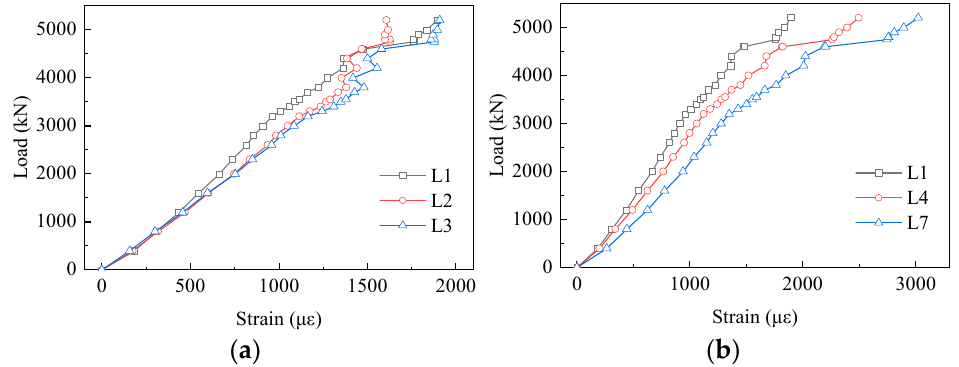
Figure 11. Load–strain curves of the tensile truss-web member: ( a ) L1, L2, L3; and ( b ) L1, L4, L7; L1: No. 1 strain gauge of tensile truss web.